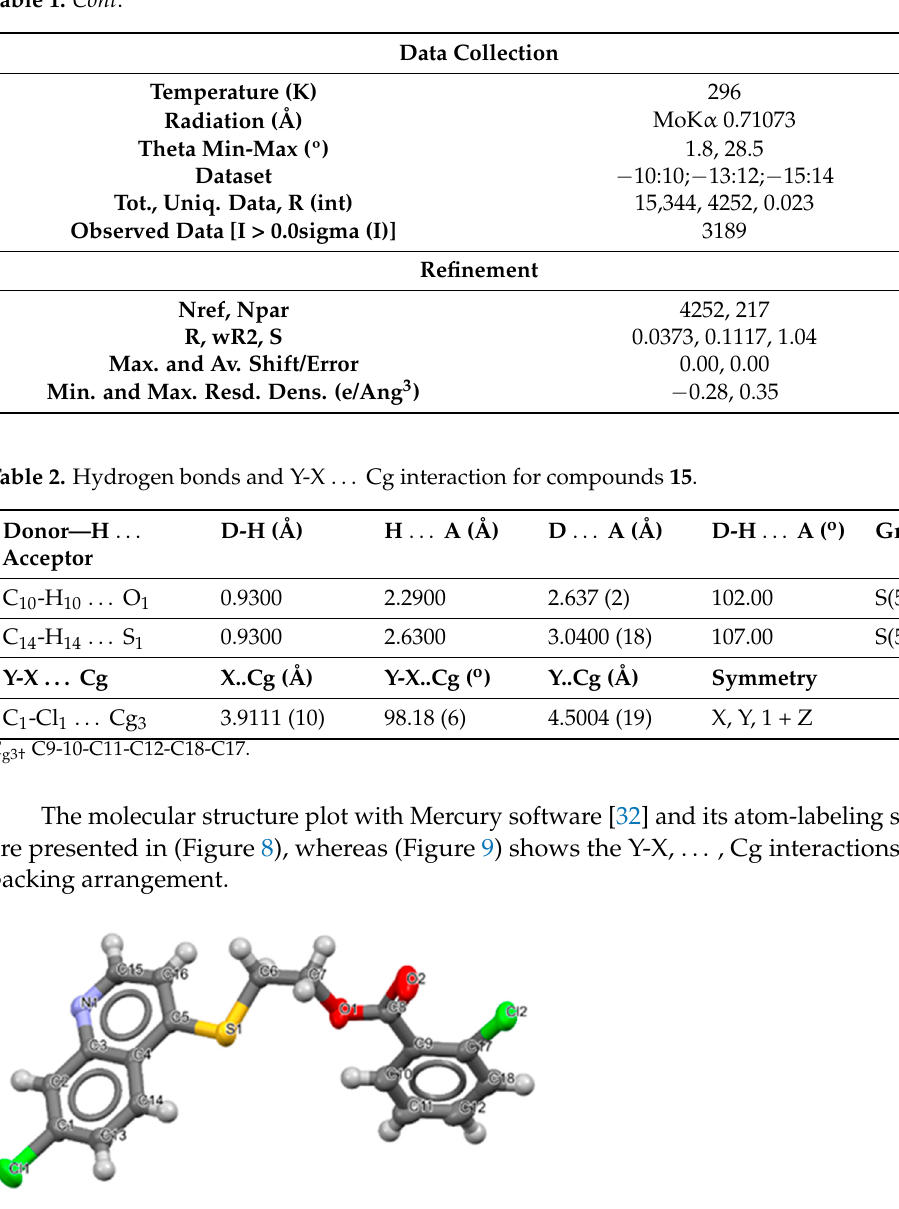
Figure 8. View of compound 15 with its atom-labeling scheme.